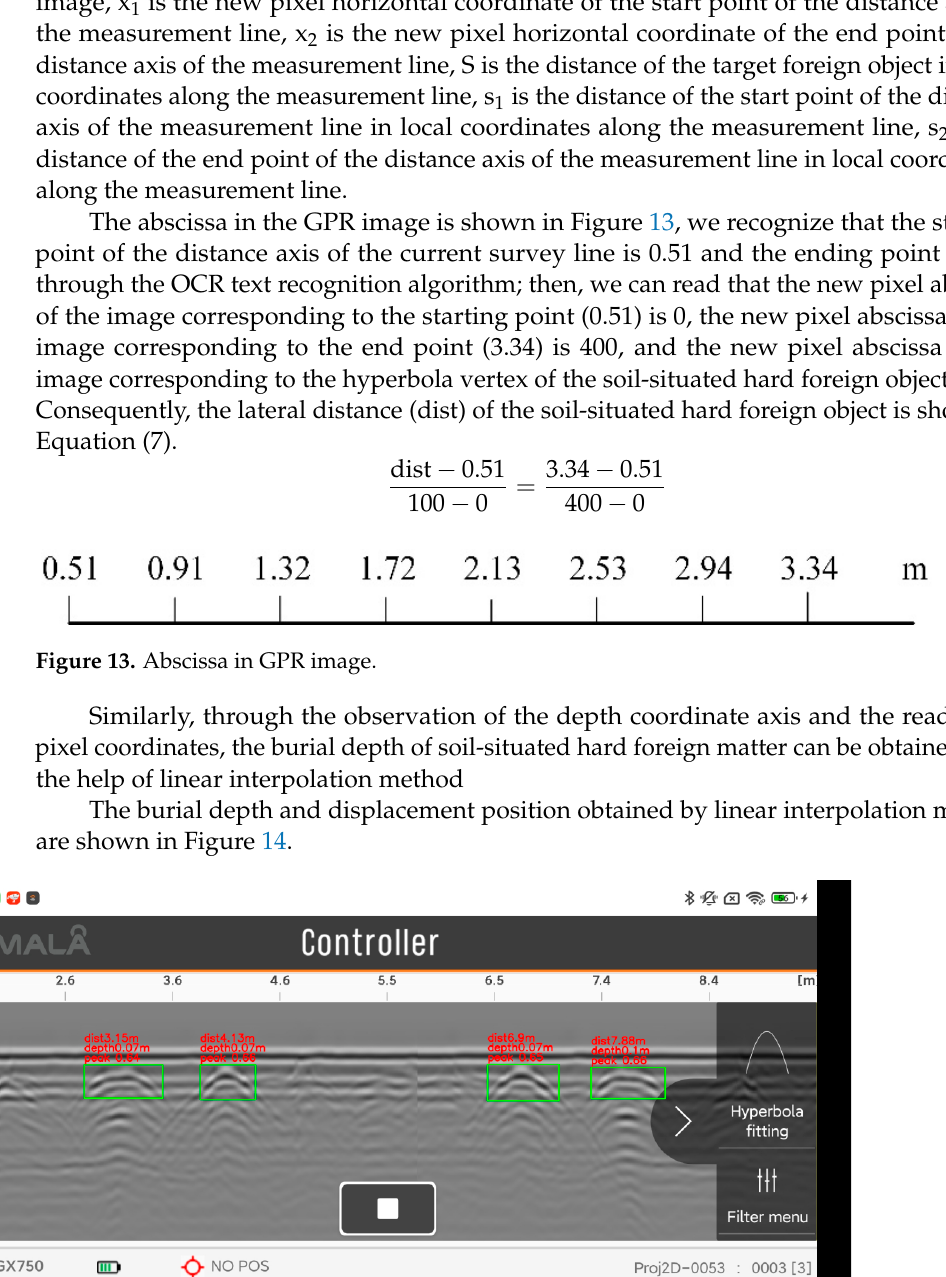
16 of 21 Figure 12. Reconstructed image pixel coordinate map.